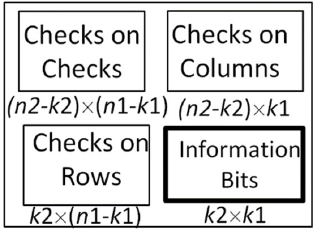
Figure 2. Code array of size n 2 × n 1 for an ( n 1 × n 2, k 1 × k 2) product code.